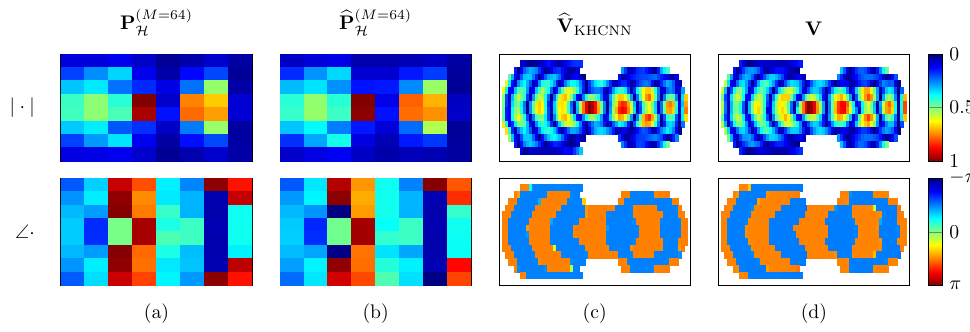
Figure 12. Reconstruction example of KHCNN for a violin top plate vibrating at 1829Hz. The magnitude and phase of the complex fields are represented in the first and second row, respectively. Column ( a ) is the input pressure at the hologram in M = 64 points. The hologram pressure computed with the KH propagation is shown in column ( b ). The velocity estimate and ground truth are depicted in column ( c , d ),